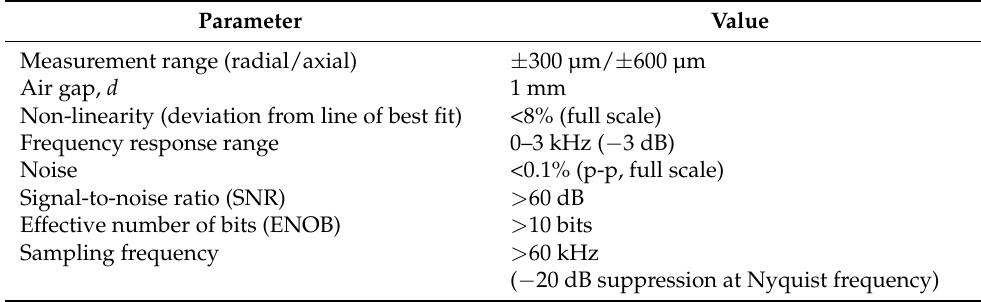
Table 1. Requirement specification for the inductive